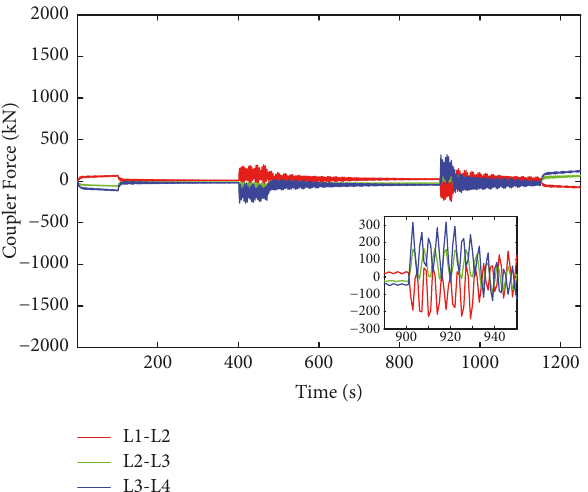
Figure 6: The coupler force among locomotives in Scenario A.